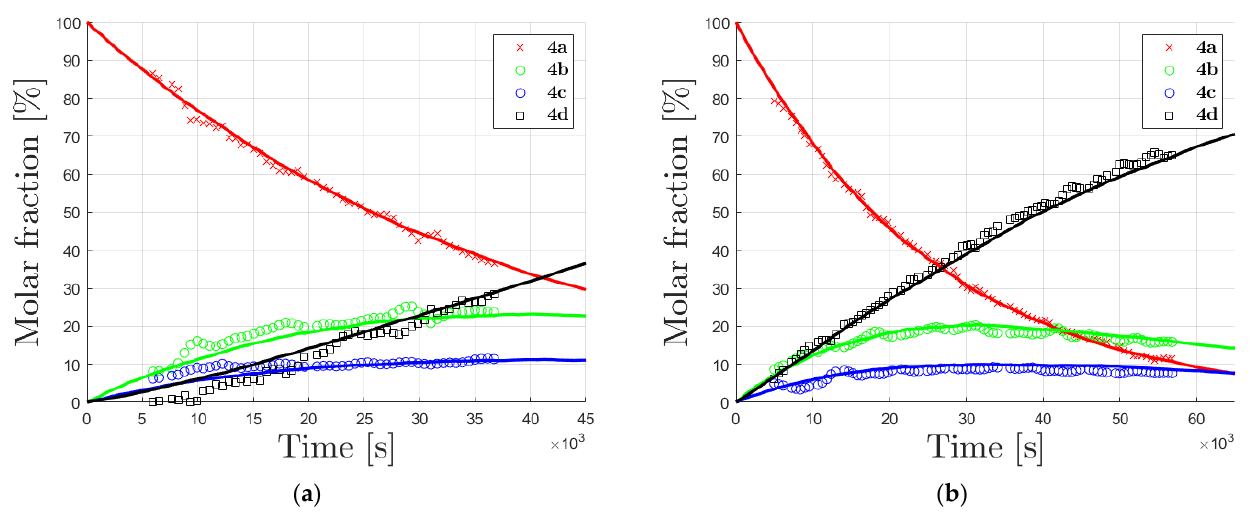
Figure 4. Experimental kinetic data and best fitting curves for the deuteration processes of 4a ( a ) at T = 300 and ( b ) at T = 305 K.